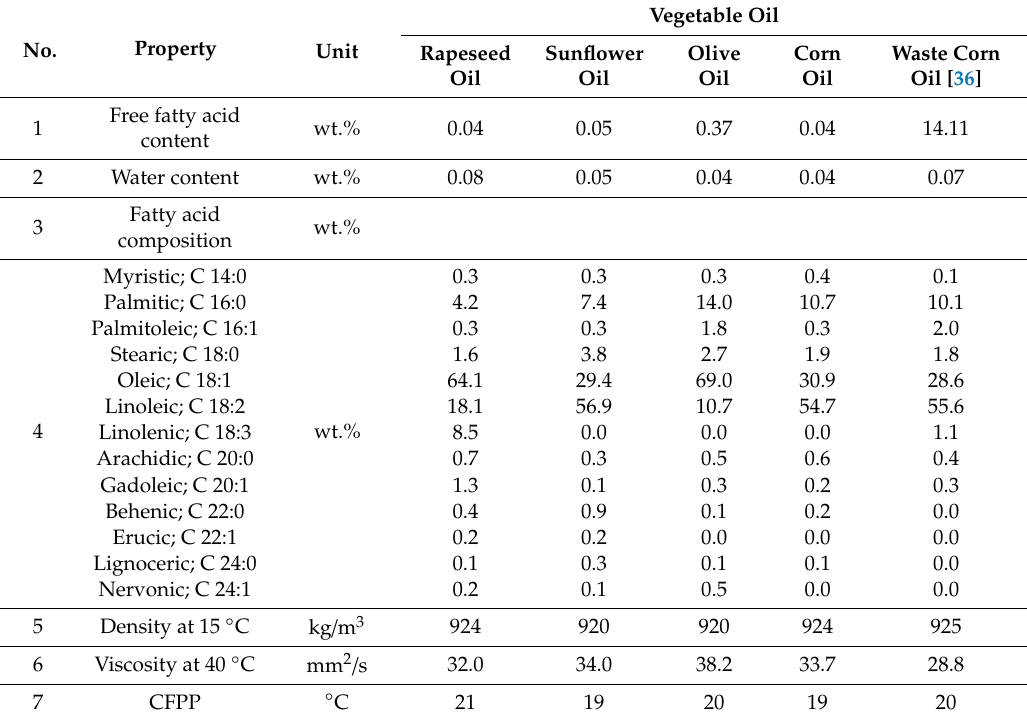
Table 4. Properties of vegetable oils used in the transesterification